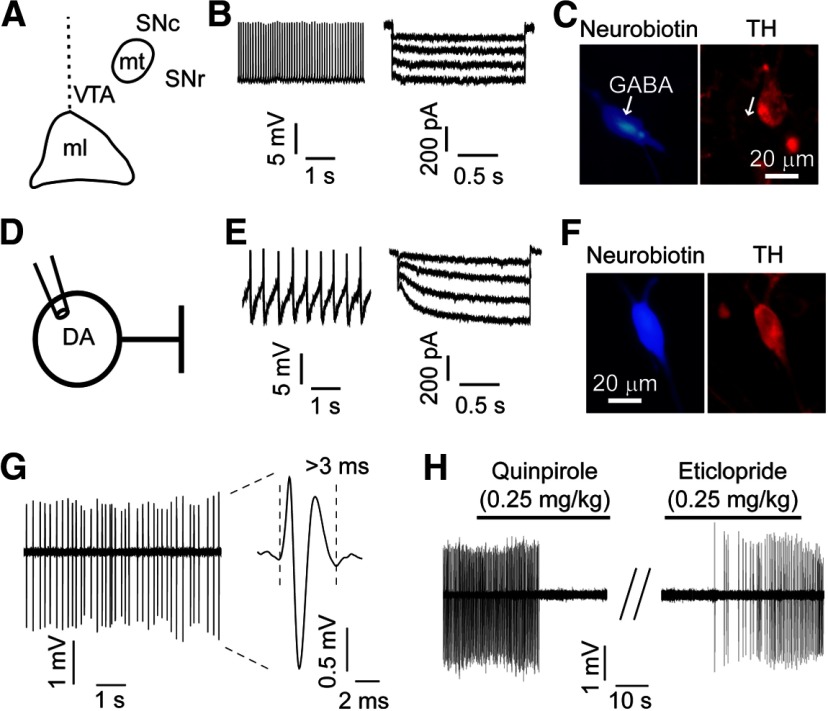

Ex vivo and in vivo identification of GABA and DA neurons in the lateral VTA. A, The lateral VTA was identified as medial to the medial terminal nucleus of the accessory optic tract (mt) and lateral and rostral to the crest of medial lemniscus (ml). SNc = substantia nigra pars compacta; SNr = substantia nigra pars reticulata; ml = medial lemniscus; mt = medial terminal nucleus of accessory optic tract. B, VTA GABA neurons displayed fast spontaneous firing rates (>7 Hz) and lack of Ih. The firing rates of VTA GABA neurons were recorded in cell-attached configuration in passive voltage-follower mode. Ih was recorded in whole-cell configuration using voltage step protocol (−40 to −110 mV in 10-mV steps, 1.5-s duration, traces on B displayed for steps from −80 to −110). C, Neurobiotin-labeled VTA neurons with these electrophysiological properties were immunonegative for TH, consistent with a non-DA phenotype. D, Ex vivo patch clamp recordings of DA neurons were performed in the lateral VTA. Spontaneous firing rate of DA neurons was measured using the cell-attached configuration, and the whole-cell configuration was used to identify DA neurons electrophysiologically and histochemically on termination of the recording. E, VTA DA neurons displayed low spontaneous firing frequency (<5 HZ) and large Ih (>150 pA). F, Neurobiotin-labeled DA neurons with these electrophysiological properties were immuno-positive for TH (red stain). G, In vivo single-unit recordings of VTA DA neurons in anesthetized rats. Example traces for putative DA neurons showing low-frequency spontaneous firing (<10 Hz) and broad triphasic action potential (>3 ms). H, Putative DA neurons were inhibited by the D2-type receptor agonist quinpirole (0.25 g/kg). This effect was then reversed following the D2-type receptor antagonist eticlopride (0.25 g/kg).